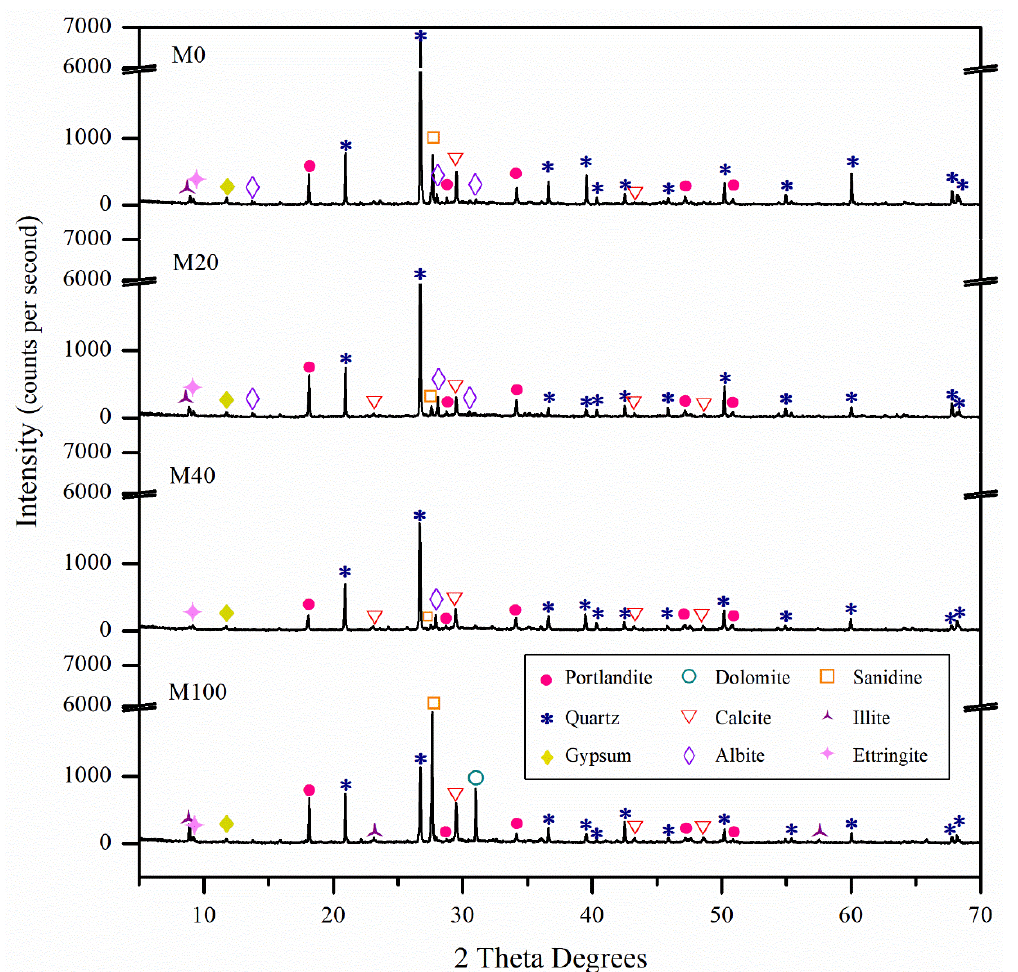
Figure 3. X-ray di ff raction patterns of conventional mortar Figure 3. X-ray diffraction patterns of conventional mortar family.